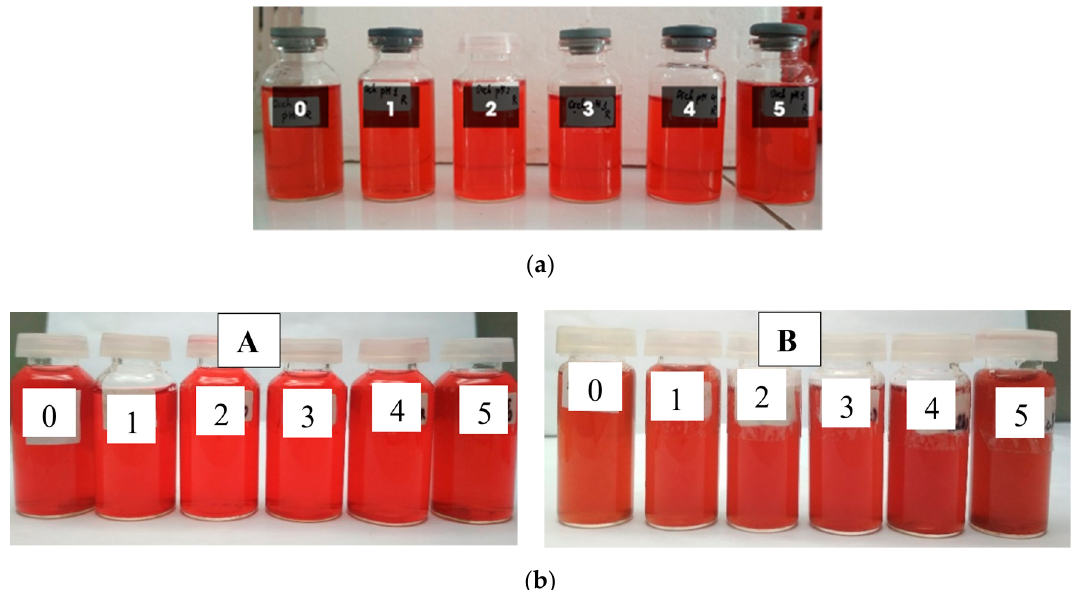
Figure 12. The change of color of the dried extract from Carissa carandas fruit ( a ) at the initial week, ( b ) after 4 weeks at room temperature (A), and after 4 weeks at 45 °C (B).